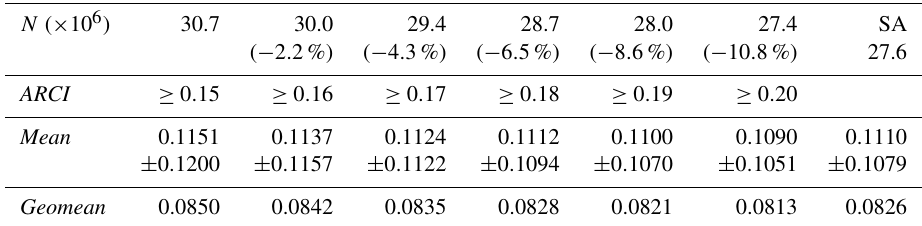
Table 3. Additional statistics for the data presented in Fig.